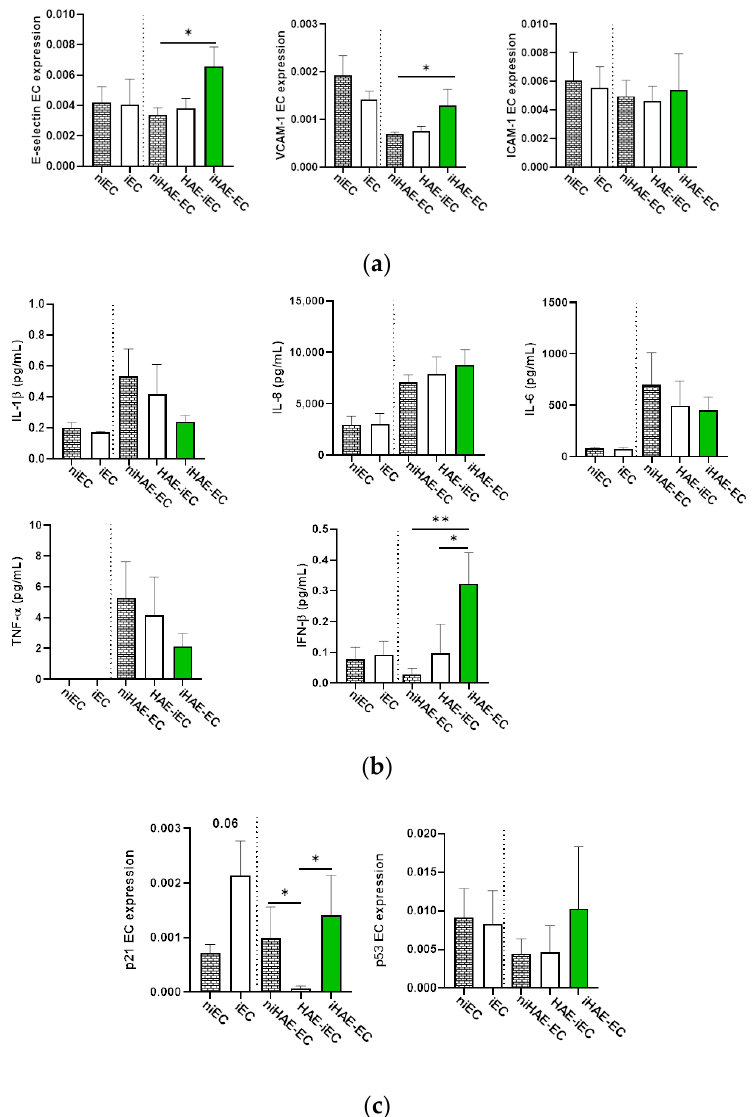
Figure 3. SARS-CoV-2 Viral replication in HAE induces IFN- β release and modulation of p21 expression in ECs. ECs gene expression analysis of adhesion molecules, senescence markers, and quantification of inflammatory cytokines and IFN- β levels. Data are presented in three different culture conditions (n = 6): (i) EC cultured alone, (ii) infected EC co-cultured with HAE (HAE-iEC) and (iii) infected HAE co-cultured with EC (iHAE-EC). As a control, uninfected EC cultured alone or in co-culture with HAE (nEC and nHAE-EC) are reported. ( a ) ECs gene expression analysis of E-selectin, ICAM-1, and VCAM-1; ( b ) Quantification of inflammatory cytokines (IL-1 β , IL-6, IL-8) and IFN- β in the supernatant of indicated cultures; ( c ) ECs gene expression analysis of p21 and p53. Values are presented as mean ± SEM. Mann-Whitney test was used for group comparison. * = p < 0.05; ** = p <